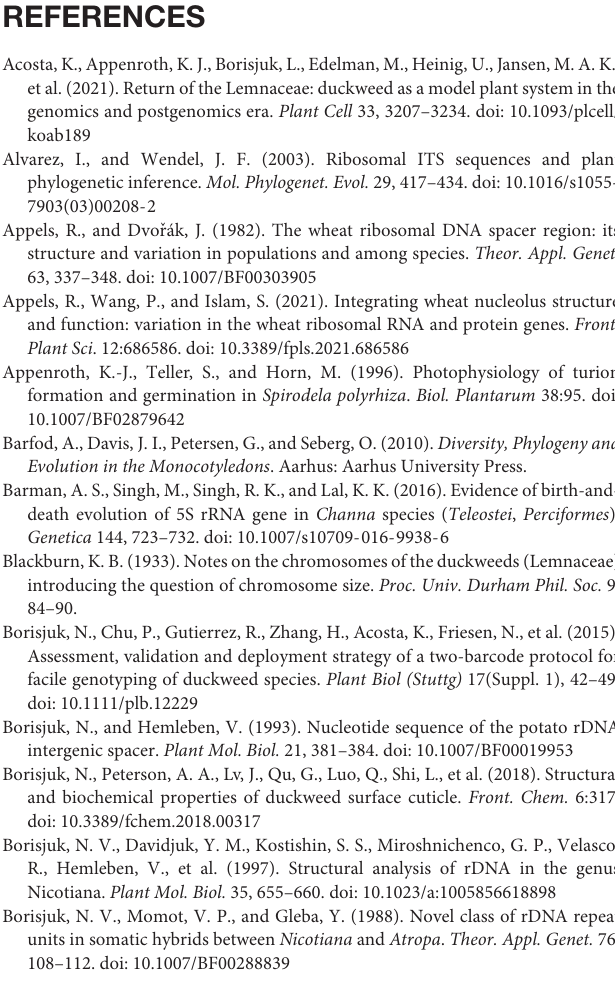
Supplementary Figure 8 | Nucleotide alignment of Type I-a, I-b, I-c, I-d, II-a, and II-b 5S NTS sequences from P. stratiotes . Variable residues and regions are